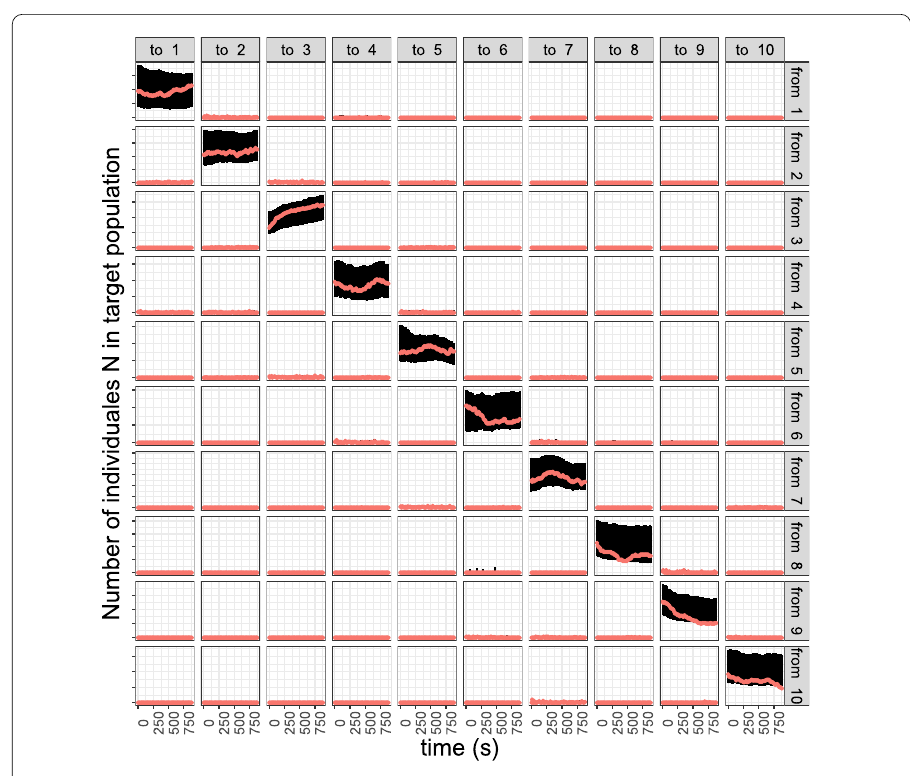
Figure 20 Credible intervals for the OD matrix. Credible intervals (prob = 95%) for OD matrix compared to true values (in red) computed according to the whole module integration with the RSS geolocation model with uniform prior and the beta negative binomial with rb reg = 0 and cv reg =